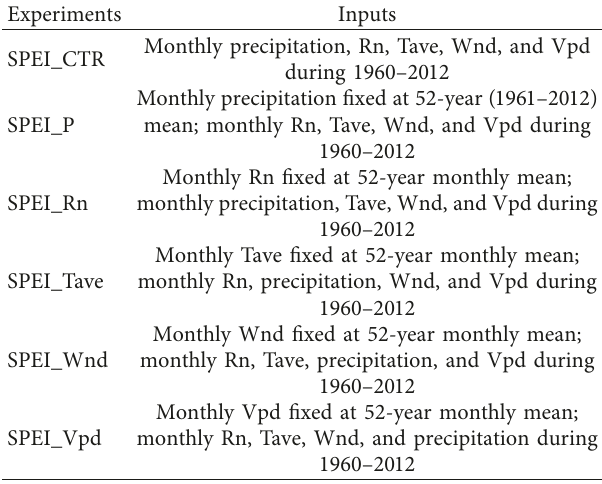
Table 1: Detailed information about numerical